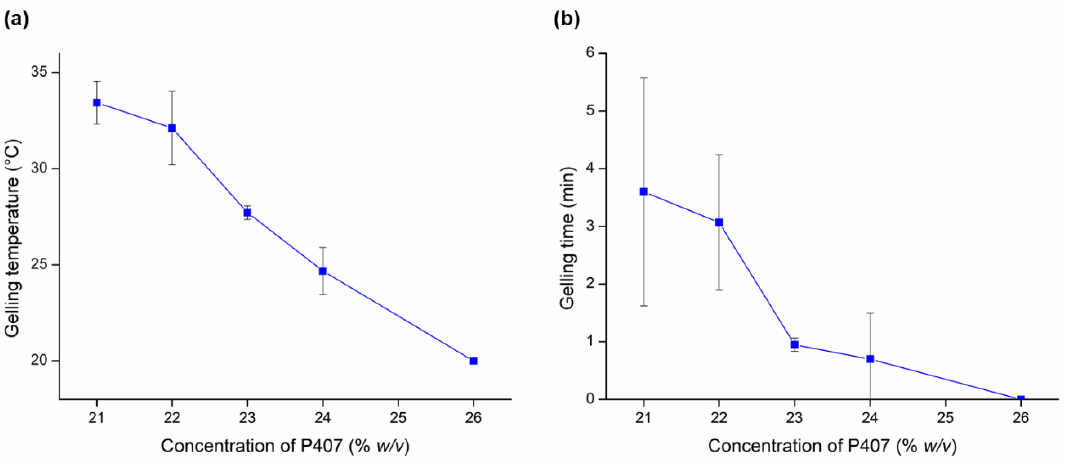
Figure 2. In situ gelling properties of nasal formulations with different P407 concentrations on gelling temperature ( a ) and gelling time at 35 °C ( b ). Data are presented as means ± SD, n = 3.